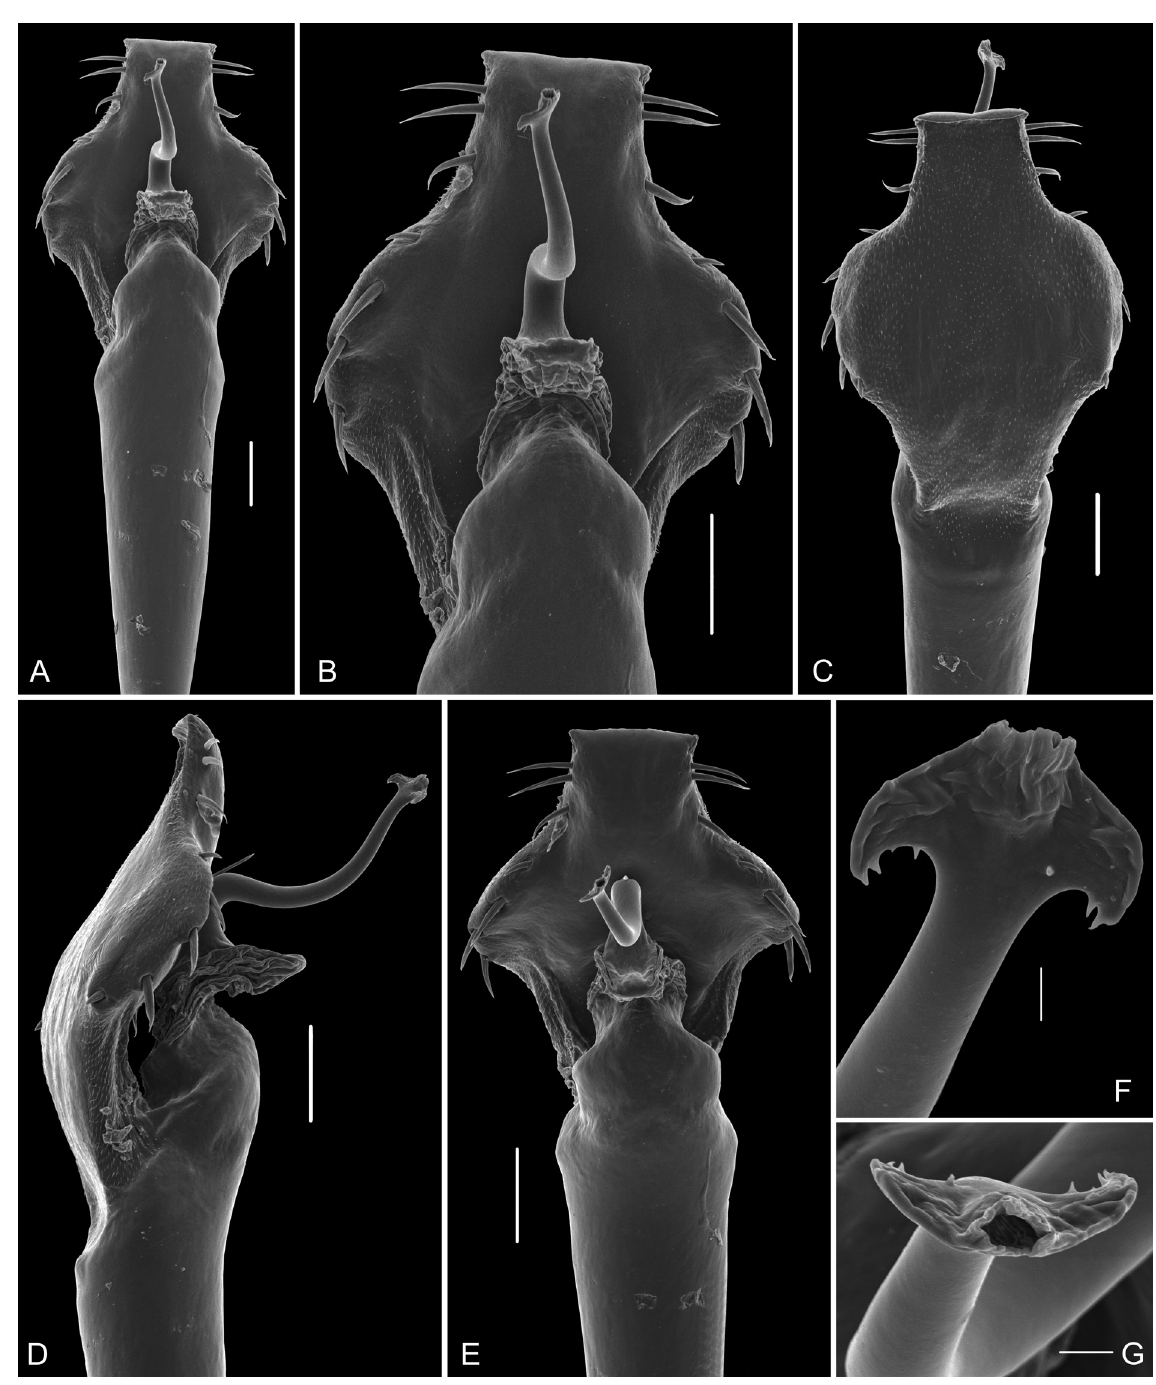
Fig. 6. Amazochroma carvalhoi (Mello-Leitão, 1941) gen. et comb. nov. (MNRJ 8801); ♂, genitalia, distal part. A . Dorsal view, panoramic. B . Same, greater magnification showing glans. C . Ventral view. D . Lateral view. E . Dorso-apical view. F . Stylus, apex, apical view. G . Same, dorsal view. Scale bars: A–E = 100 μ m; F–G = 10 μ